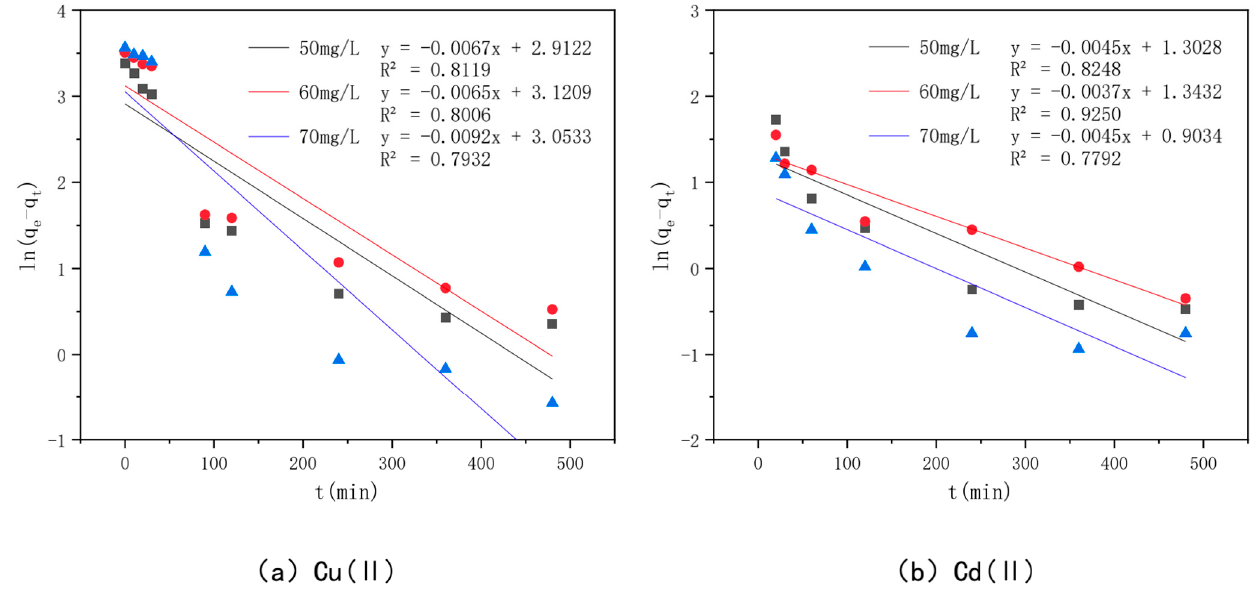
Figure 11. Pseudo-first-order kinetic models of different concentrations of Cu(II)/Cd(II).